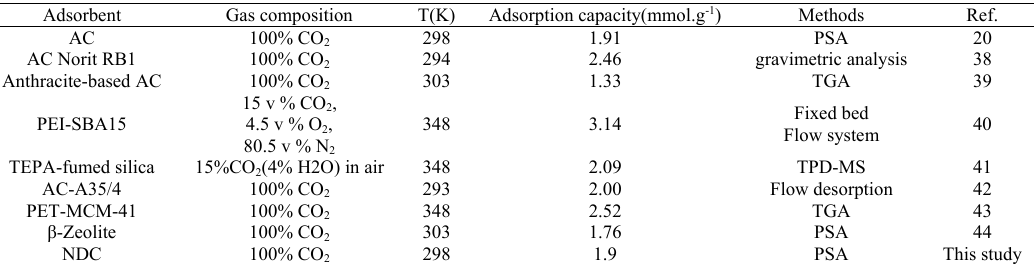
Table 3 Comparison of CO 2 adsorption capacity with other adsorbents. Table 3. Comparison of CO adsorption capacity with other 2 Adsorbent Gas composition T(K)